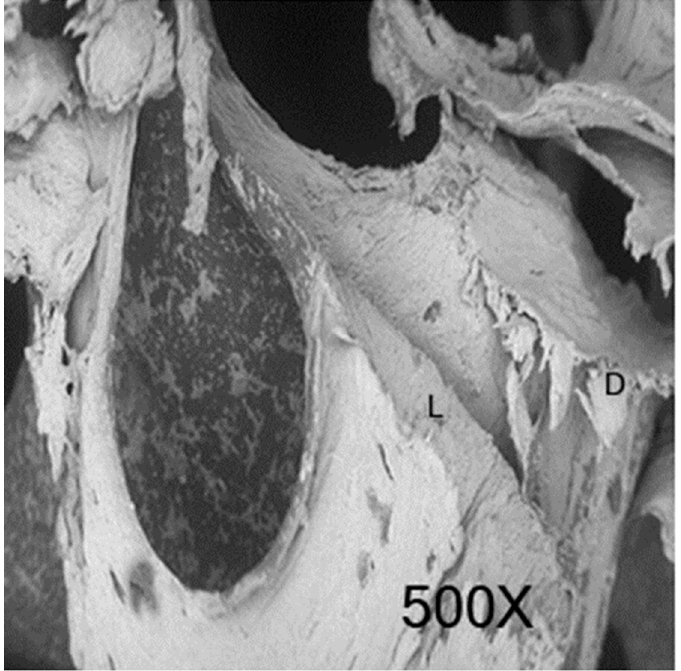
Figure 1. Stainless steel diamond bur sample surface (D—debris, L—laceration).